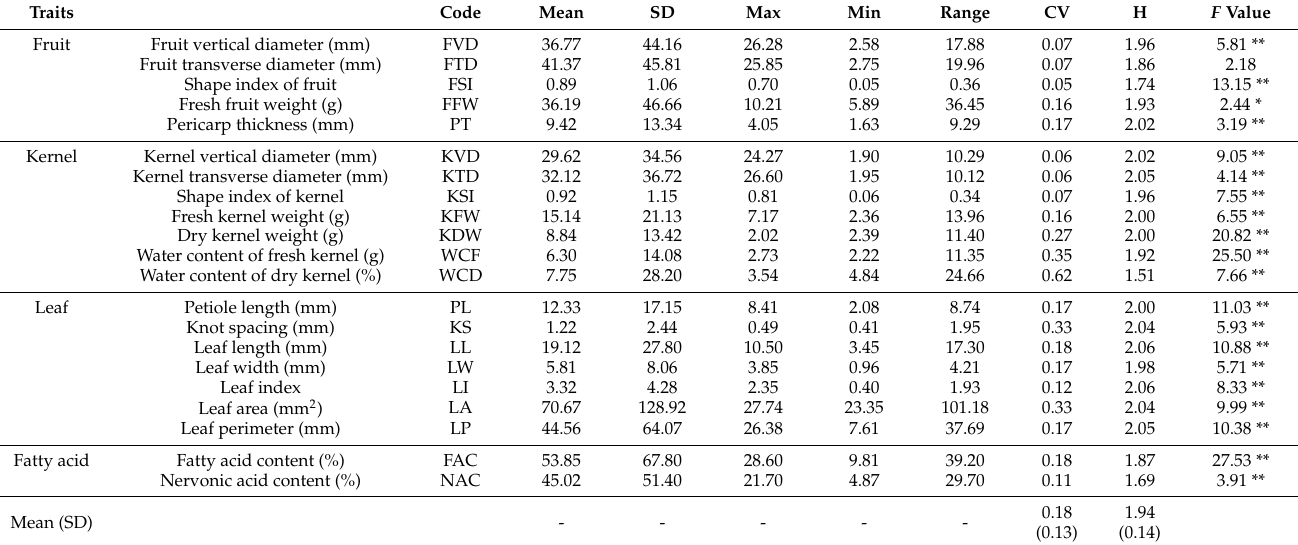
Table 2. Variation and diversity of the 21 traits in seven natural populations of M. oleifera (* and ** denote significance for p < 0.05 and p < 0.01,